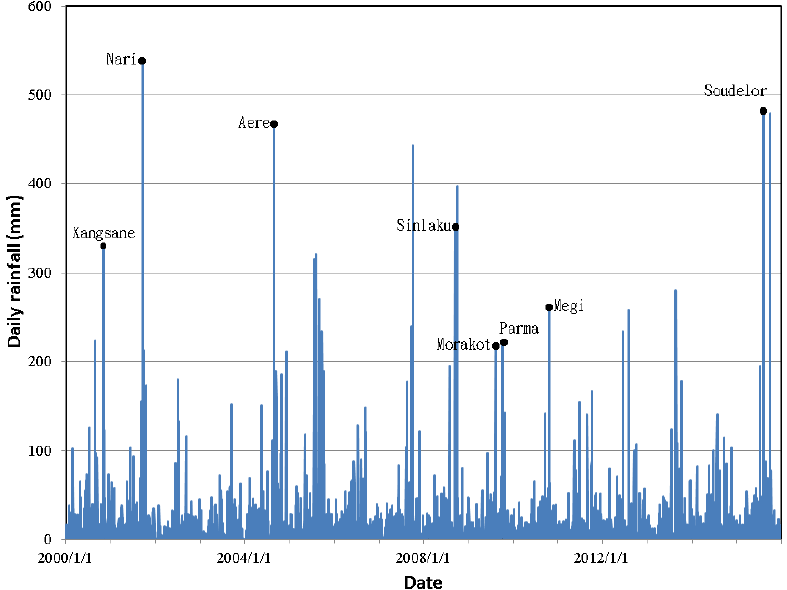
Figure 2. Average daily rainfall within the Taipei Water Source Domain, 2000–2015. The dots represent the eight typhoon events causing the corresponding landslide inventory.